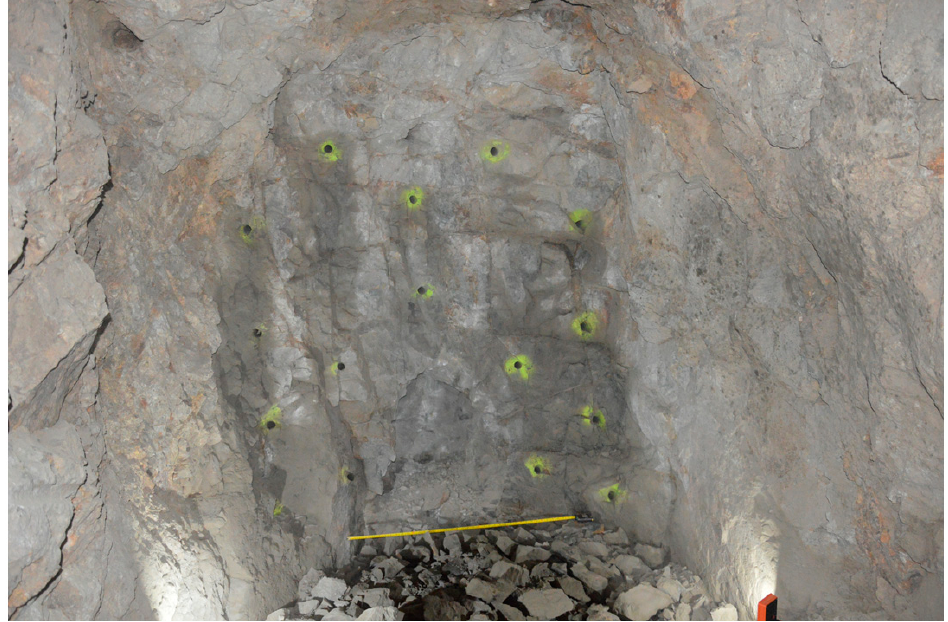
Figure A6. Cavity after detonation of hole with sequence number 5.